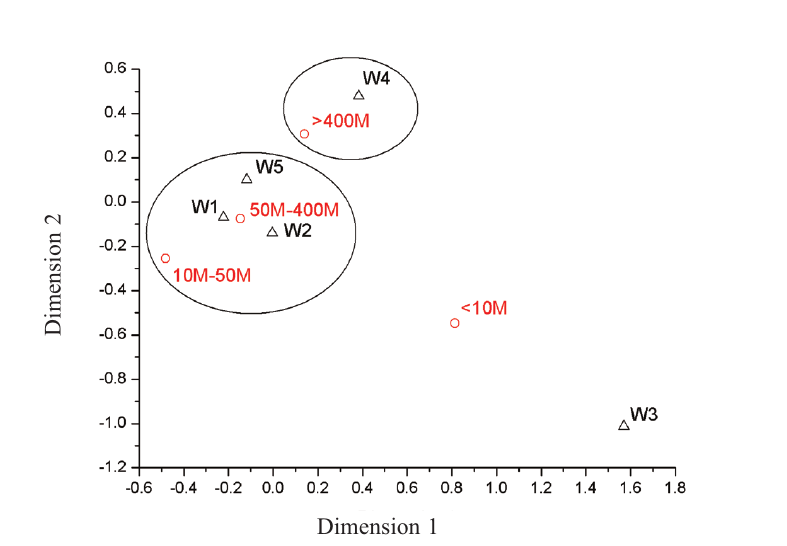
Fig. 3. Positioning maps between firms’ scale and internationalized